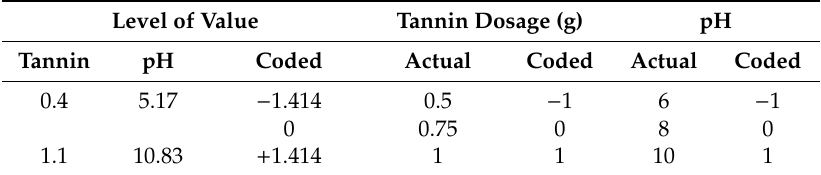
Table 2. The pH levels and tannin dosages for central composite design (CCD) with axial